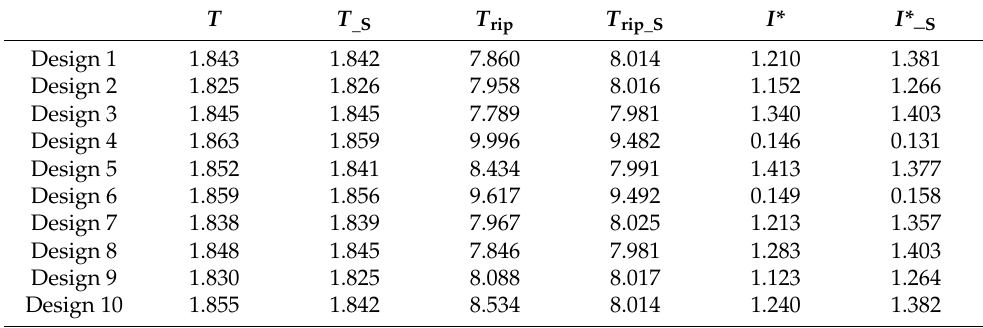
Table 4. Comparison between the optimization results and FEM.